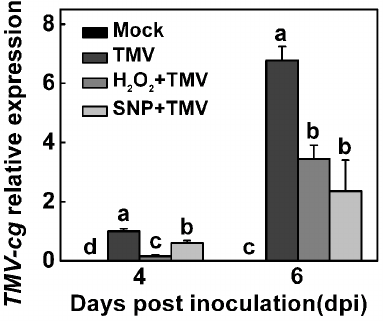
Figure 8. Effects of exogenous H 2 O 2 and NO on TMV infection in Arabidopsis plants. Effects of exogenous application of hydrogen peroxide (H 2 O 2 ) and nitric oxide (NO) and TMV inoculation on TMV-cg transcription in non-inoculated upper leaves of Arabidopsis plants. The non-inoculated upper leaves were pretreated with H 2 O 2 or SNP 12 hours before TMV inoculation. TMV-cg transcript levels were analyzed by real-time reverse-transcription polymerase chain reaction at 4 and 6 days post inoculation (dpi). The results are expressed as the mean 6 SD, n = 4. The letters indicate significant differences between the treatments ( P , 0.05).